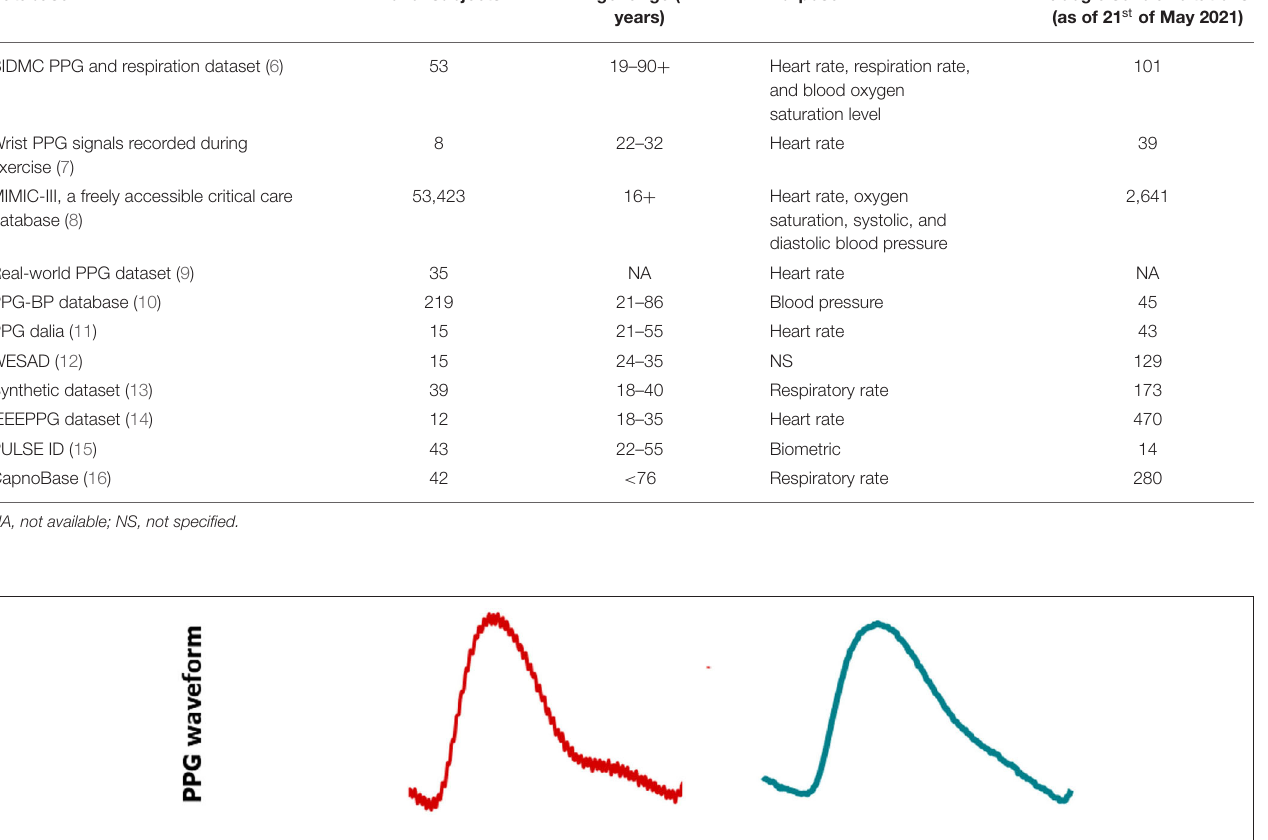
Frontiers in Medicine |